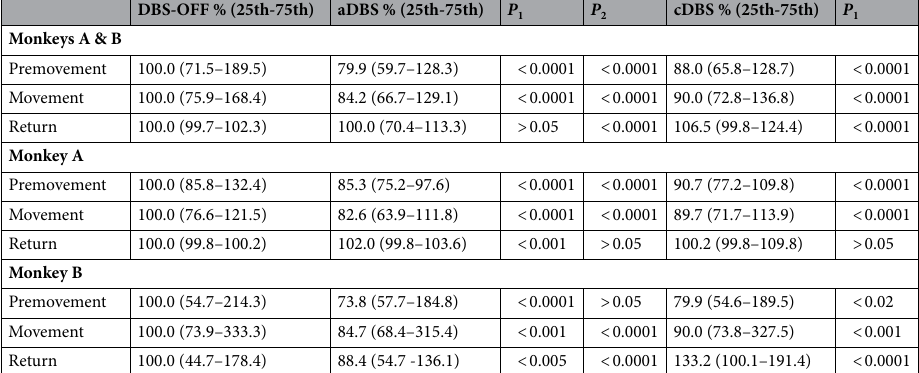
Table 3. Duration of the Premovement, Movement, and Return periods with DBS-OFF, aDBS, and cDBS. Durations of the Premovement, Movement, and Return periods were expressed as percentage ratios and ranges (25th-75th percentile) to values in DBS-OFF. P 1 , P values in post hoc comparisons to DBS-OFF; P 2 , P values in post hoc comparisons to cDBS.